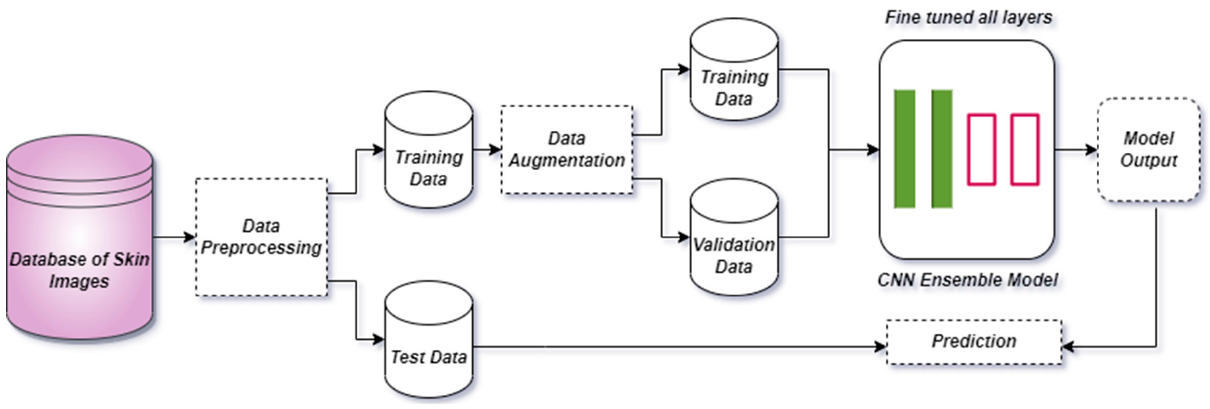
Figure 1. System architecture of the proposed methodology.